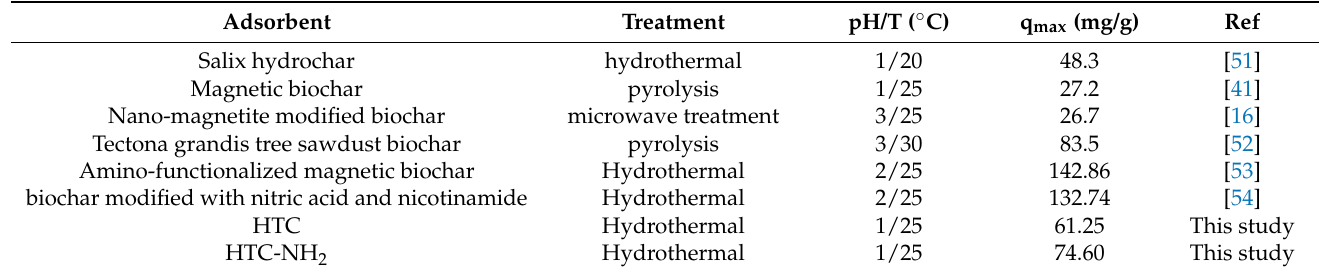
Table 4. Comparison of adsorption capacities with similar carbon